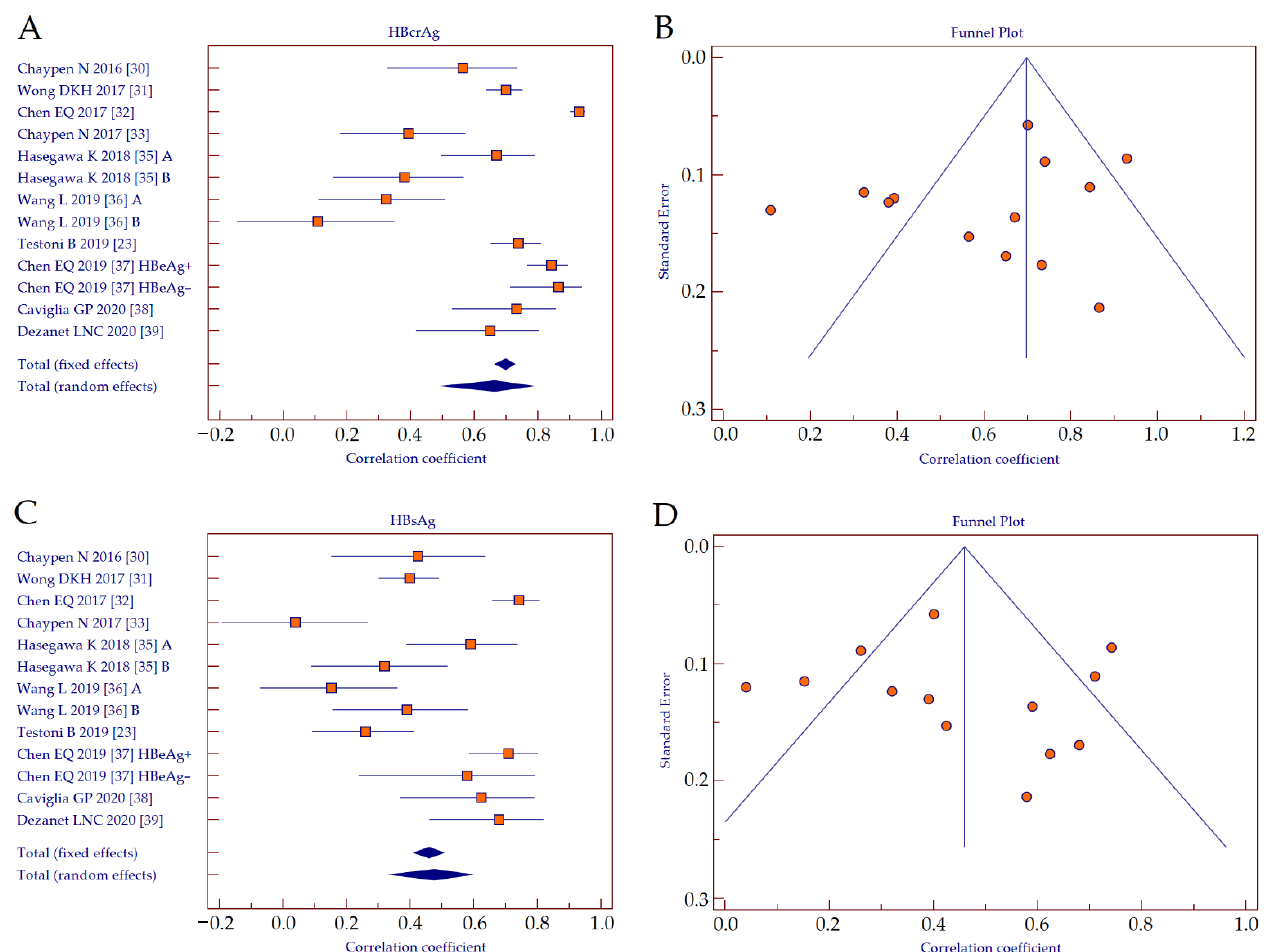
Figure 4. Forest plot ( A ) and funnel plot ( B ) of the correlation between serum HBcrAg and intrahepatic HBV cccDNA, and forest plot ( C ) and funnel plot ( D ) of the correlation between serum HBsAg and intrahepatic HBV cccDNA. Abbreviations: hepatitis B core-related antigen (HBcrAg), hepatitis B surface antigen (HBsAg), hepatitis B virus (HBV), covalently-closed- circular DNA (cccDNA).